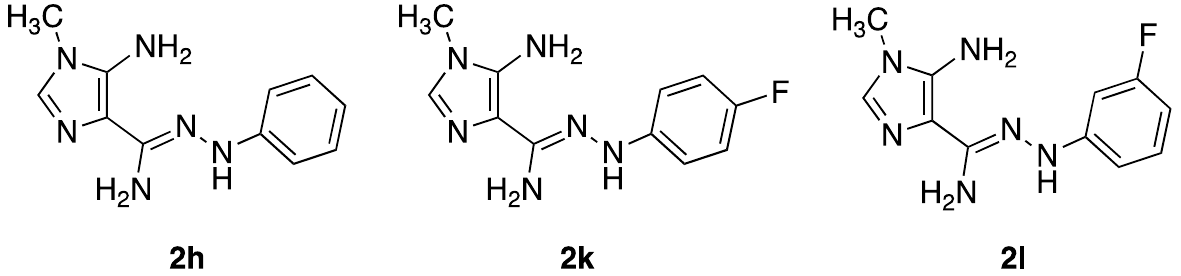
Figure 1. Lead antifungals: ( Z )-5-amino- N ’-aryl-1-methyl-1 H -imidazole-4 carbohydrazonamide derivatives.